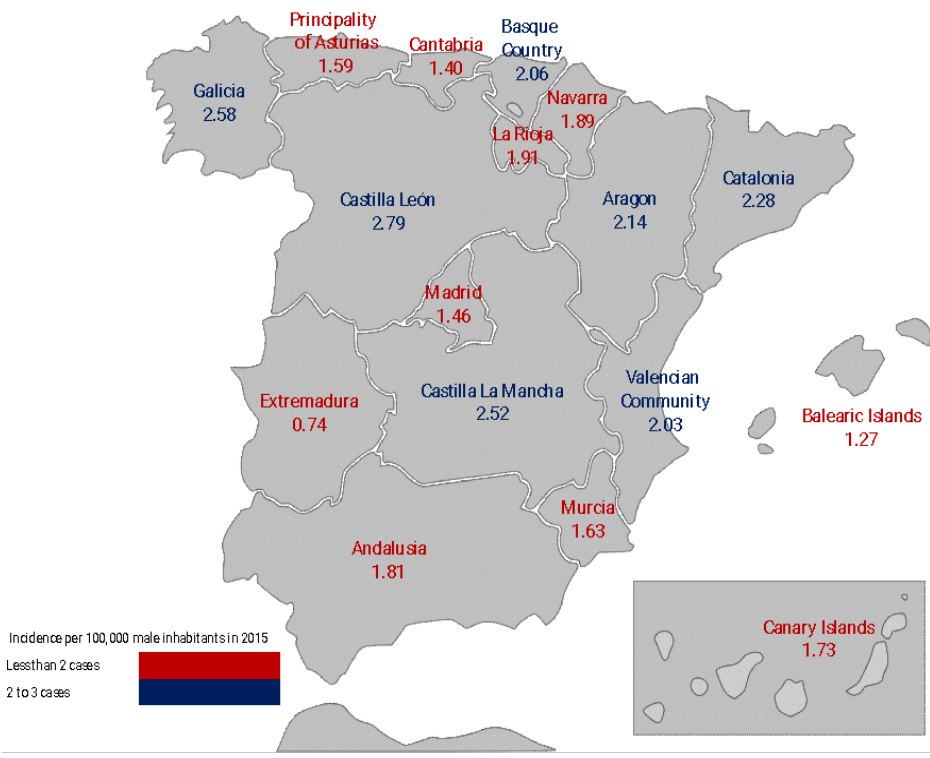
Figure 1. Incidence rate of penile cancer in the Autonomous Communities of Spain.